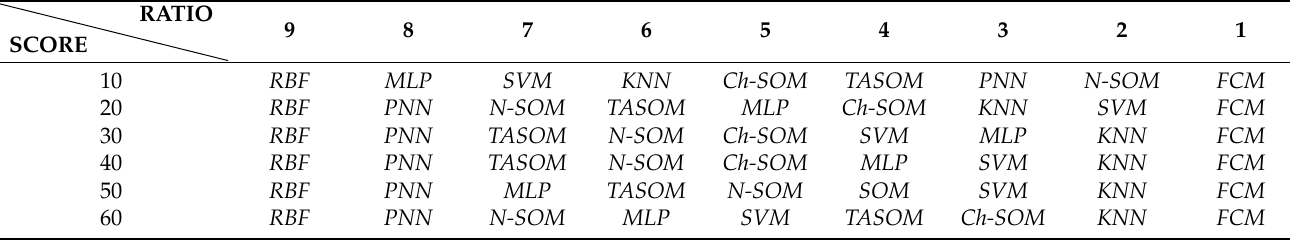
Table 5. Results for ranking of all evaluated